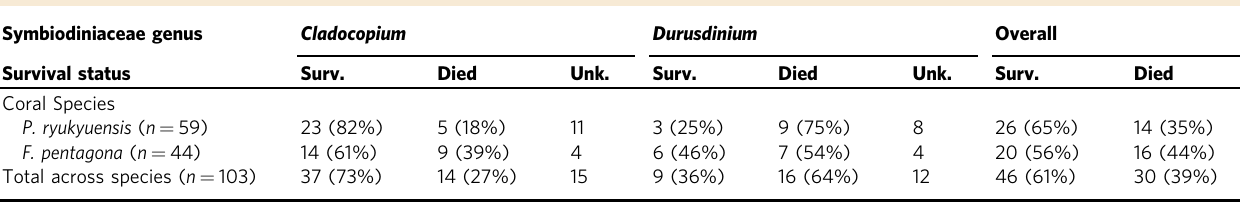
Number of colonies by outcome (survived (Surv.), died, unknown outcome (Unk.; e.g., lost colony)) late in the El Niño heatwave (March 2016), classi fi ed by starting dominant Symbiodiniaceae genus (>50% of reads). Sample sizes of colonies that were tracked, but had an unknown starting genus, becausethe initial expedition in which theywere tagged was after the start of the heat stress (e.g., July 2015 or March 2016), are not included in this table, but are as follows: P. ryukyuensis, n = 22; F. pentagona, n = 16. Percentages represent percent of colonies within each starting Symbiodiniaceae genus that were known to either survive or die (i.e., Unk. colonies are not included in these